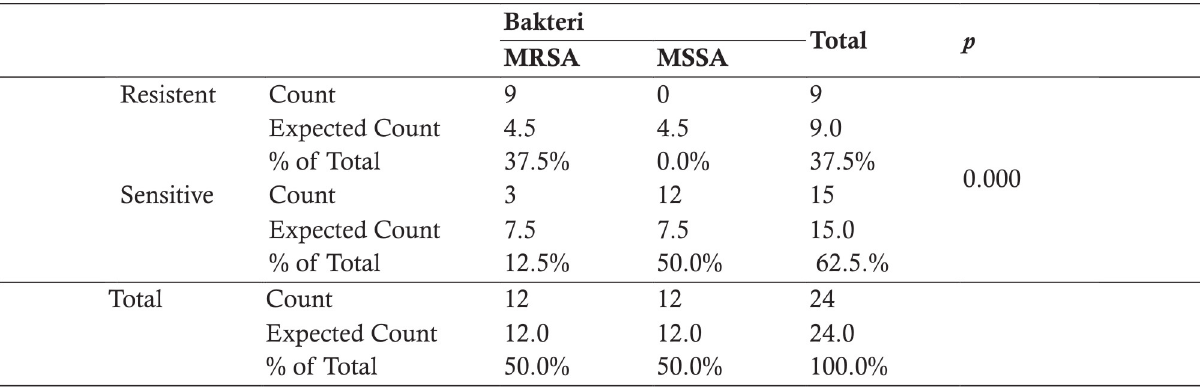
Table . Cross tabulation of oxacilin